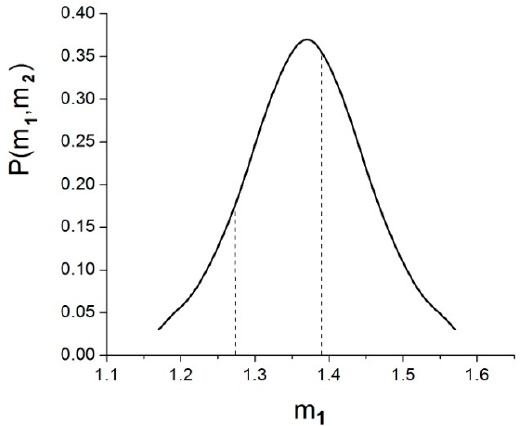
Figure 2. The construction of a joint probability P ( M 1 , M 2 ) from the reconstructed NS distribution ( top ). The dotted lines correspond to ± 1 σ around the central average value obtained from binary systems 1.33 M @ . The area under the curve outside this range is in fact > 50% and suggests an asymmetry as emerging from the reanalysis. Note that the small errors stemming from the chirp mass determination have not been taken into account and would give the solid curve a narrow strip shape.